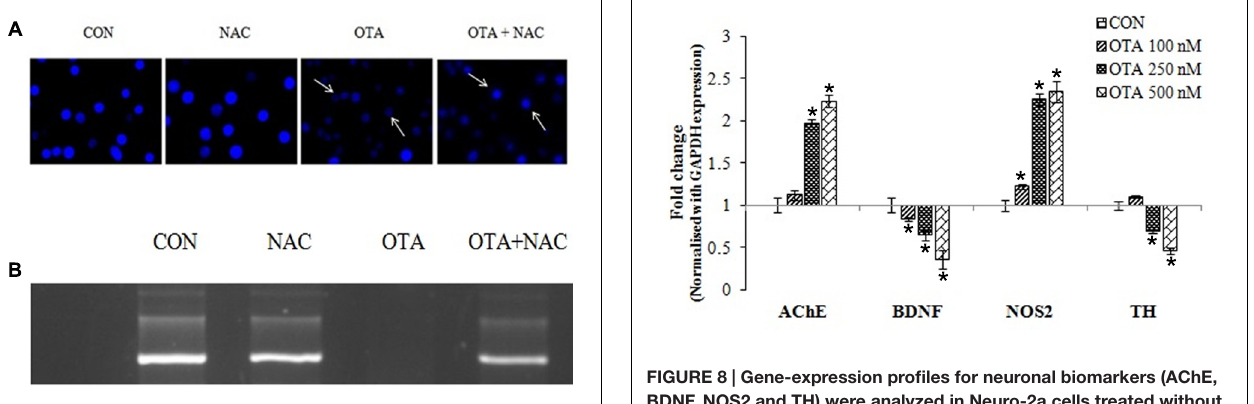
FIGURE 7 | DNA damage caused by OTA and its protection with NAC. (A) OTA induced apoptosis in Neuro-2a cells. The photomicrographs represent the levels of apoptotic nuclear damage in Neuro-2a cells pretreated with NAC (1 mM) for 24 h followed by OTA (500 nM) treatment for 24 h and photographed. (B) The protective effect of NAC on OTA induced plasmid DNA damage analysis by agarose gel electrophoresis.